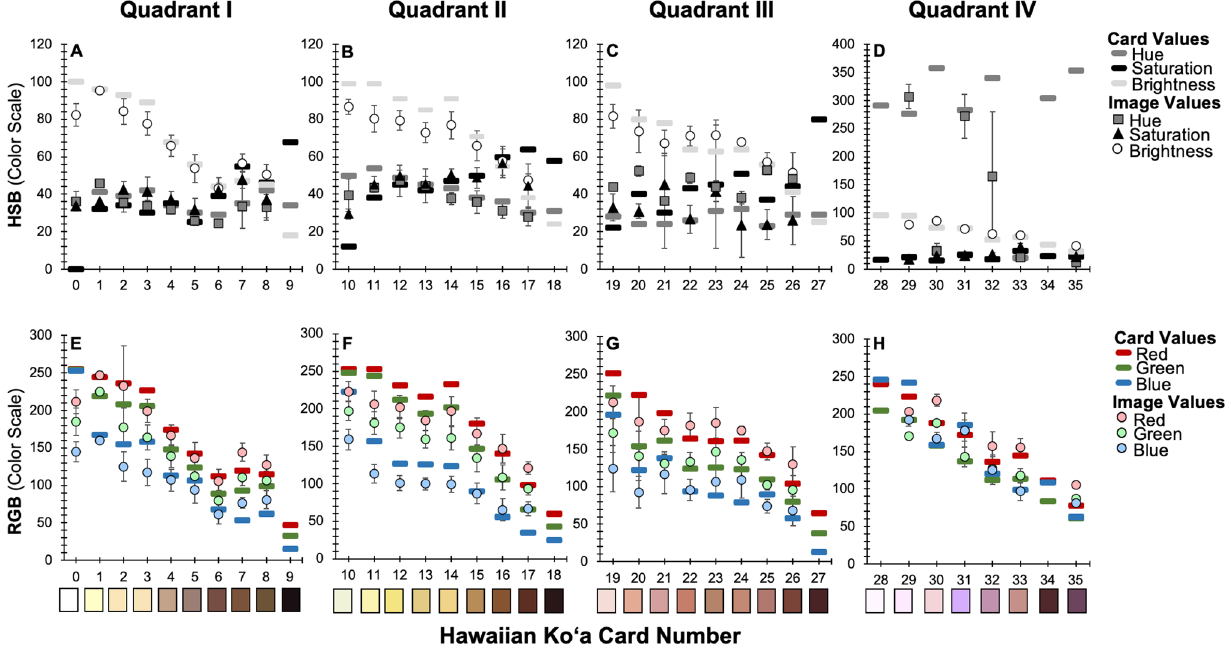
Significant values ( p < 0.05) are shown in